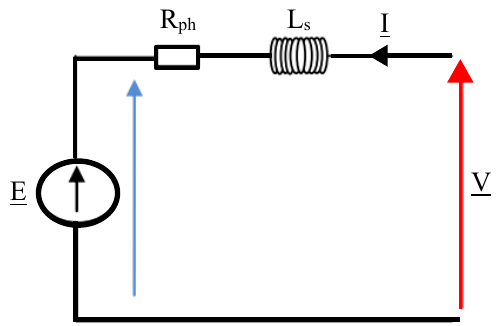
Figure 9. Per-phase equivalent electrical circuit of AFPM